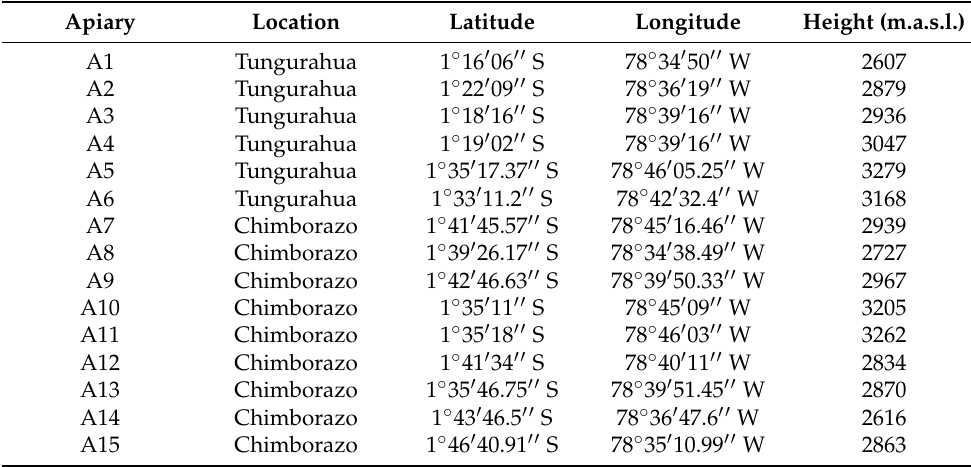
Table 1. Location of the studied apiaries in the Ecuadoran highlands.